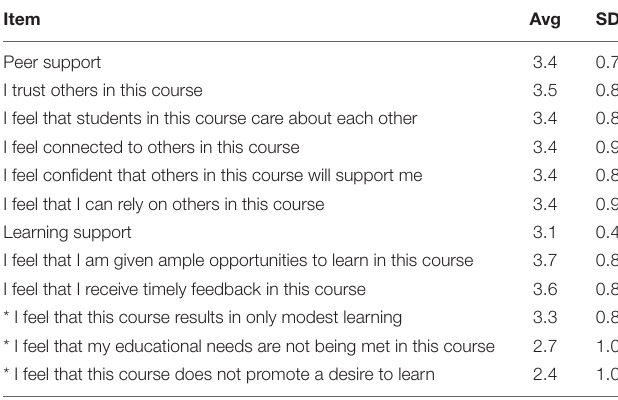
TABLE 5 | Classroom community